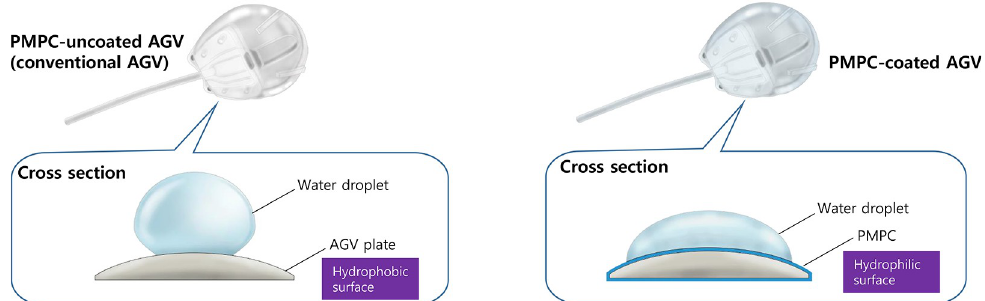
Fig 1. Comparison of the surface nature of PMPC-uncoated Ahmed glaucoma valve (AGV) and PMPC-coated AGV. The water contact angle was over 90˚ for the conventional AGV; therefore, the AGV originally had a hydrophobic surface. When the conventional AGV was coated with PMPC, the water contact angle decreased to below 90˚, which implied that PMPC-coated AGVs have a hydrophilic surface.